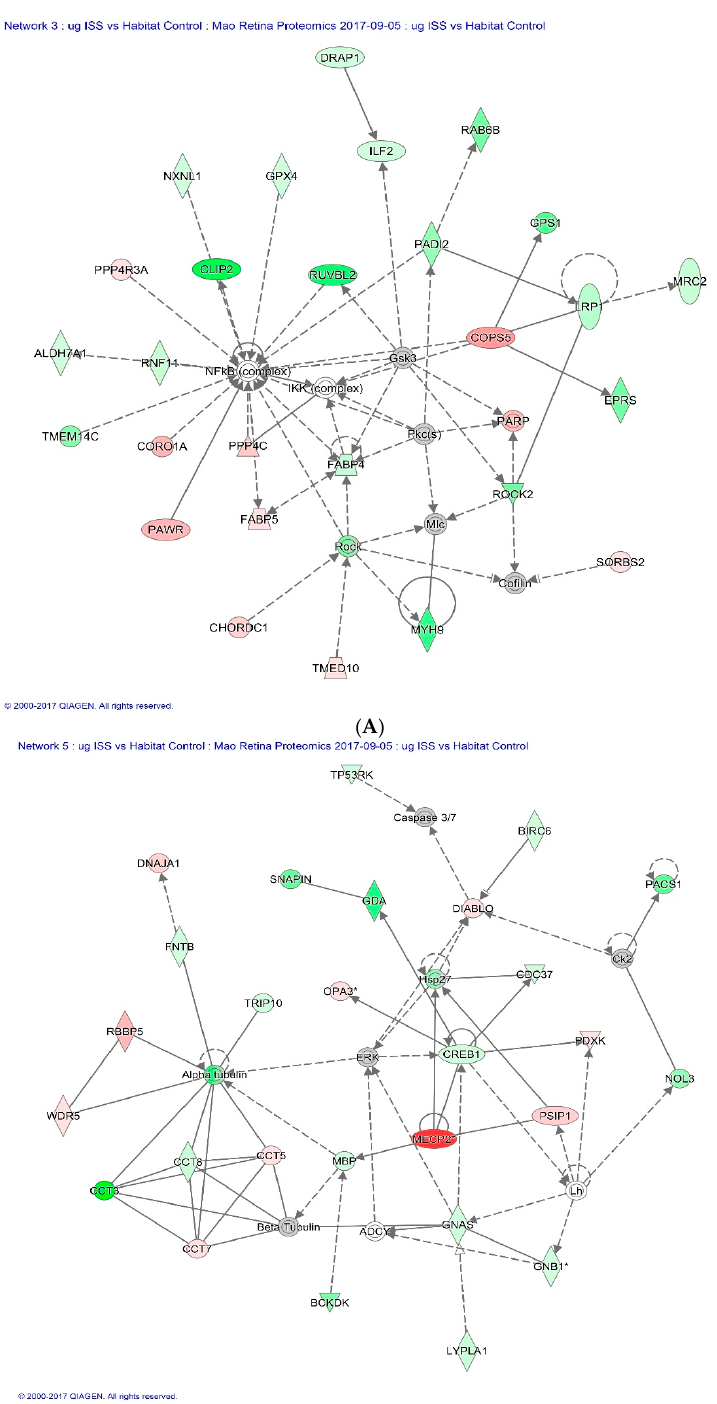
Figure 6. ( A ) Impact of spaceflight condition ( µ g group) on CLIP2 expression in the network of proteins responsible for cellular assembly and organization, cell signaling and interaction. Red = up-regulated ( p < 0.05). Grey = un-changed. Green = down-regulated ( p < 0.05); ( B ) Impact of spaceflight condition ( µ g group) on MECP2 protein expression in the network of proteins involving in cell death and survival response. Red = up-regulated ( p < 0.05). Grey = un-changed. Green = down-regulated. ( A , B ) are generated with IPA software. More detailed description of the legends (squares, circles, etc.) can be found at the Ingenuity Systems